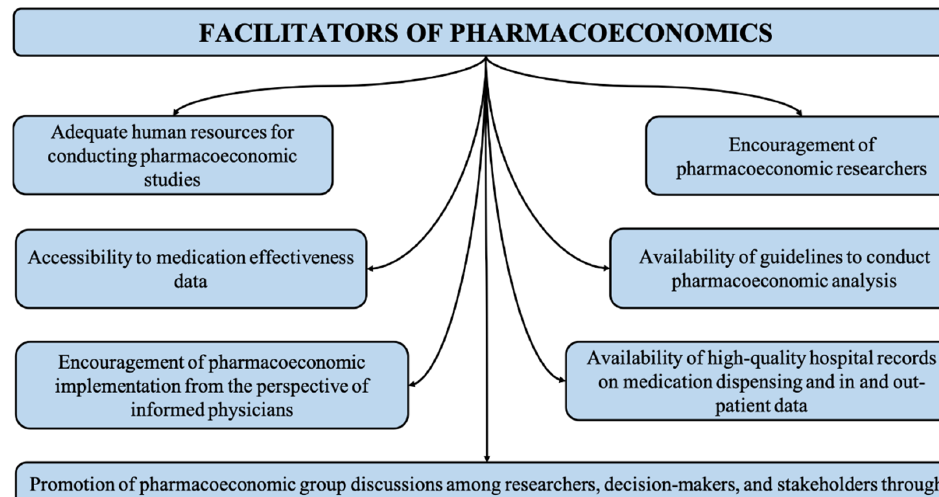
Figure 2. Illustrating facilitators of pharmacoeconomic